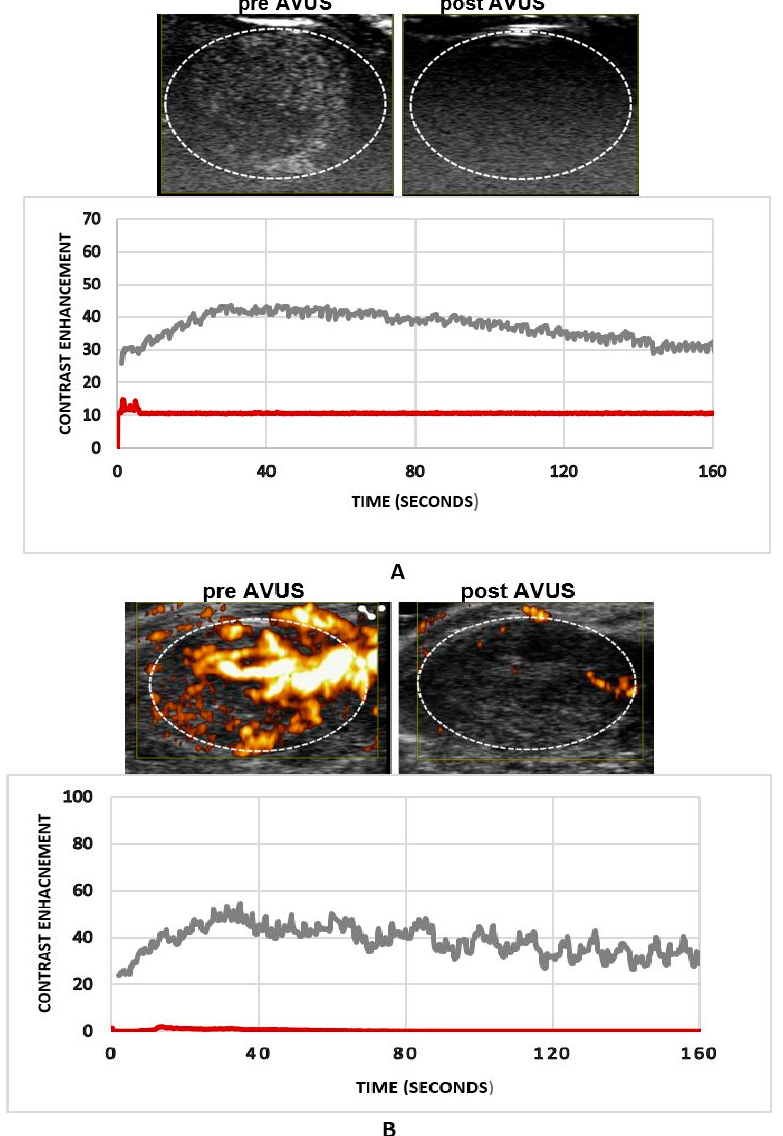
Figure 3. An example of an HCC tumor that received subsequent therapies within two days. Both NLC and PD images (panel ( A ) and ( B )) show a significant reduction (more than 90%) in tumor perfusion after therapy seen in this case. Minimal contrast flow seen in the treated tumor post